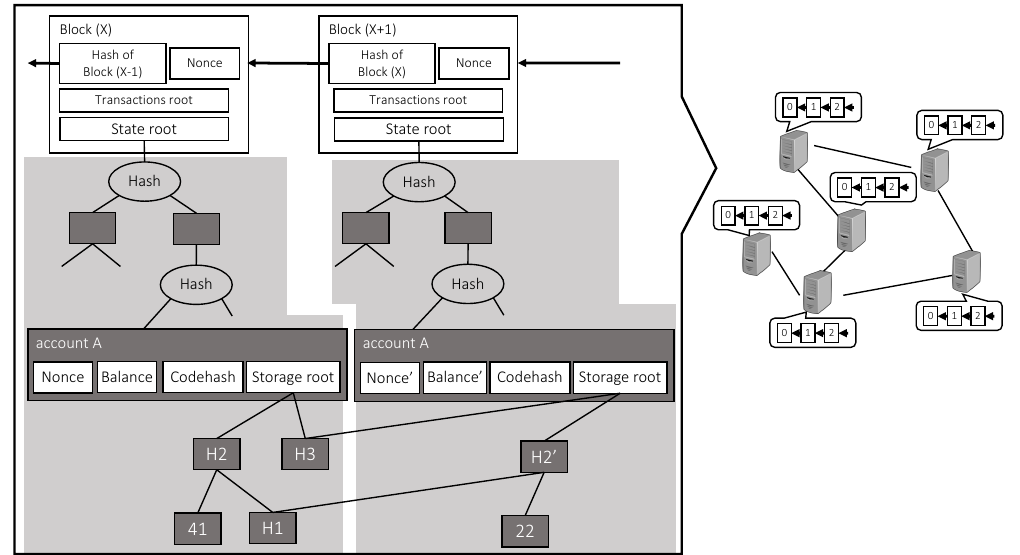
Figure 2. Data Structure of Ethereum